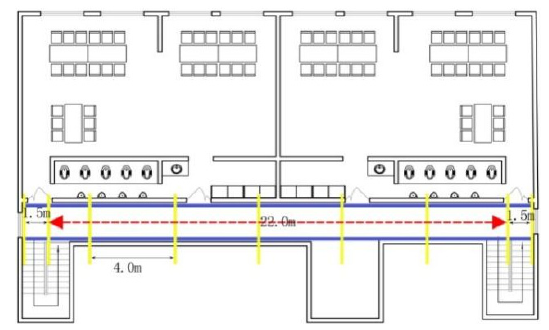
Figure 2. Test track.